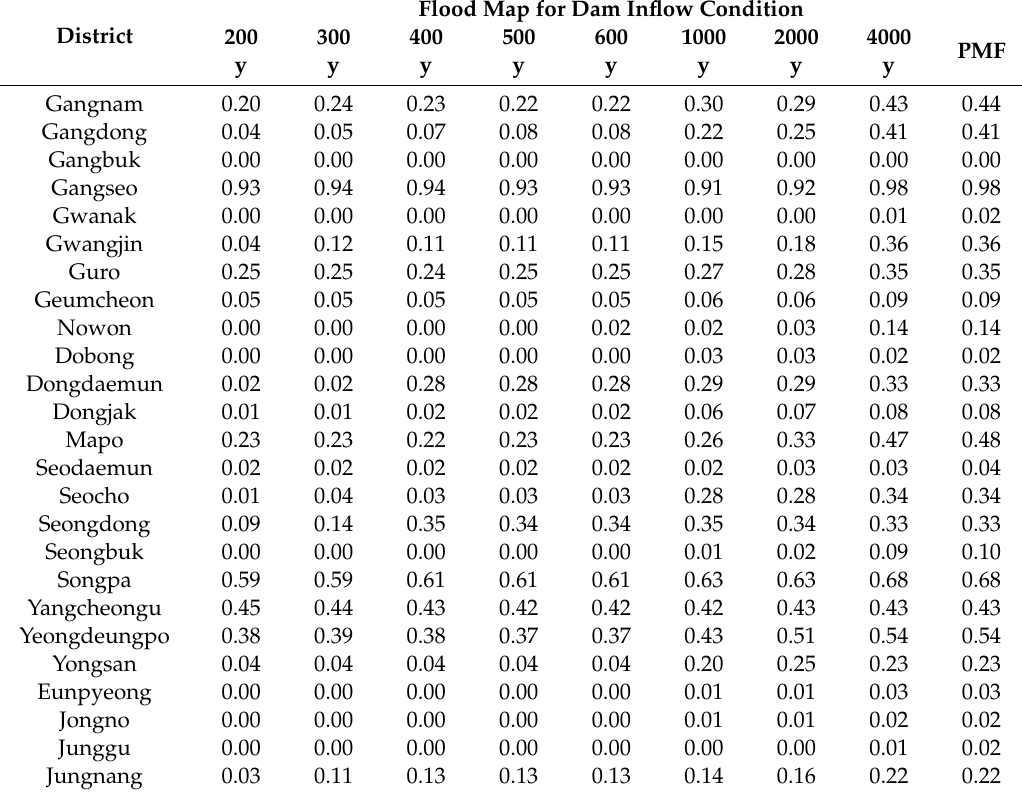
Table 3. Flood Hazard Score Considering